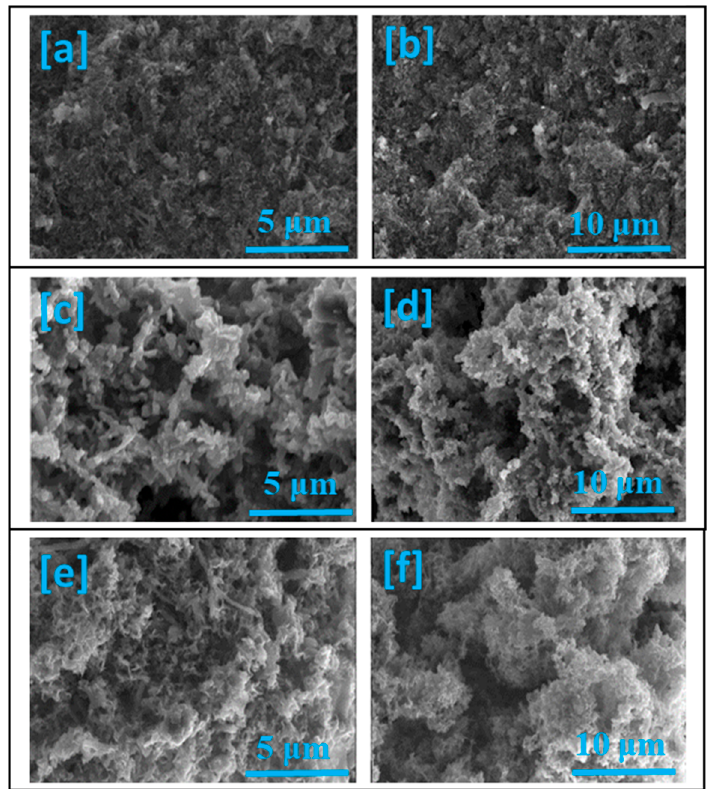
Figure 2. SEM images of PPy / GONR nanocomposites (PPyGONRs): ( a , b ) 0.5 PPyGONR, ( c , d ) 1.5 PPyGONR, and ( e , f ) 3 PPyGONR at various magnifications. Numerals indicate the weight ratio of GONRs in the nanocomposite, with the balance made up of PPy.